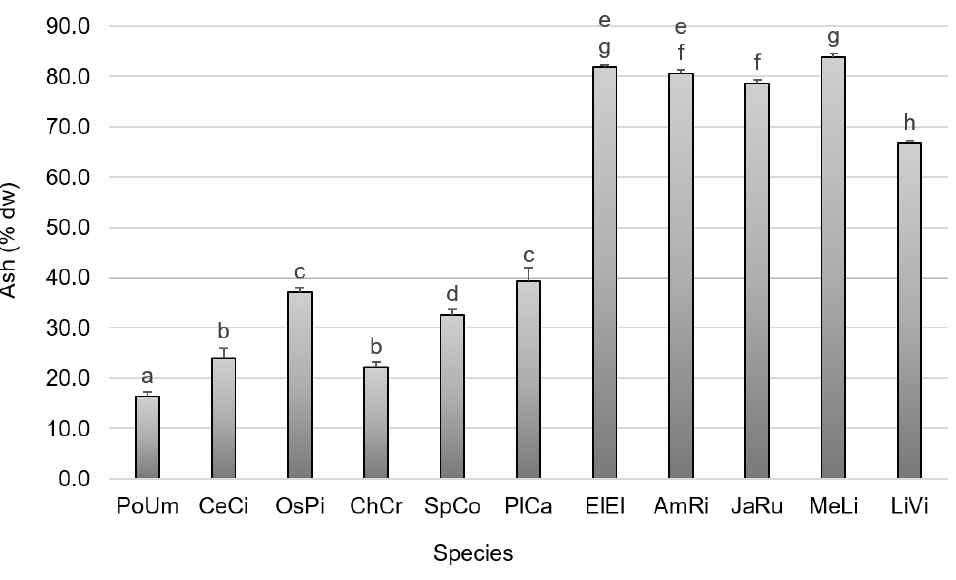
Figure 2. Ash content of the eleven studied red seaweed species expressed in % of dry weight. PoUm: Porphyra umbilicalis , CeCi: Ceramium ciliatum , OsPi: Osmundea pinnatifida , ChCr: Chondrus